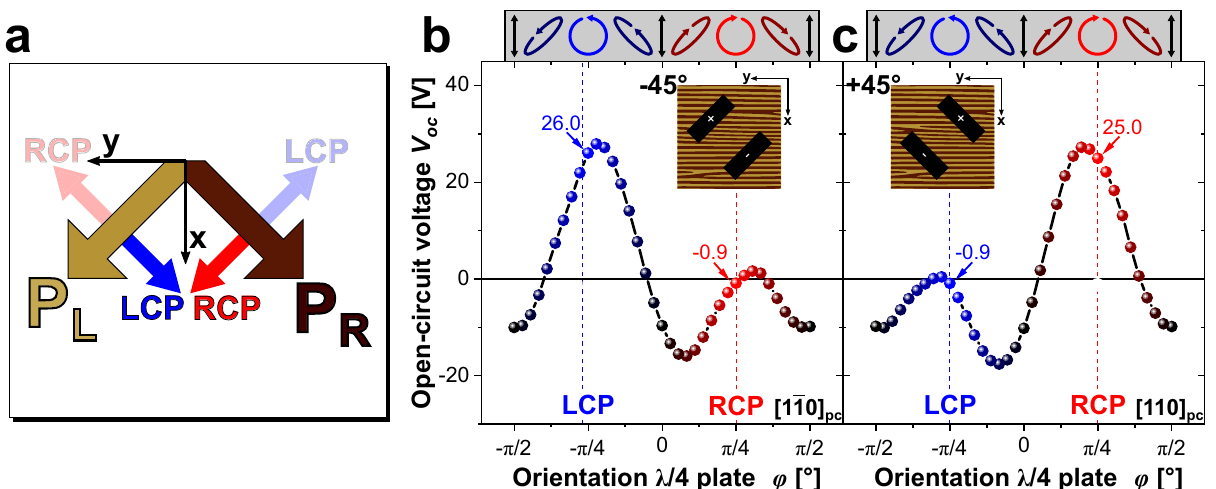
Fig. 4 Electrode alignments to show dominance of LCP over RCP response and vice versa. a Direction of V oc based on the proposed scenario above to describe the observed CBPV response (Equation 3b/3c in Table 1). The red and blue arrows implicate the direction of the V oc corresponding to RCP and LCP light, respectively. V oc as a function of λ plate orientation ϕ measured with electrodes aligned along b ½ 1 (cid:2) 10 (cid:3) 4